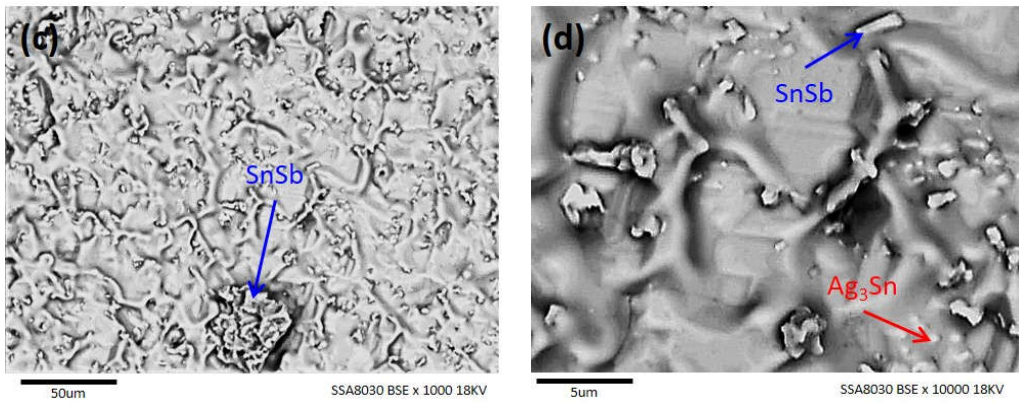
Figure 5. Fracture surface after creep testing at 175 °C: ( a , b ) SAC305 solder joints; ( c , d ) SSA8030 solder joints.